Question: Condense the content of this figure into a single sentence.
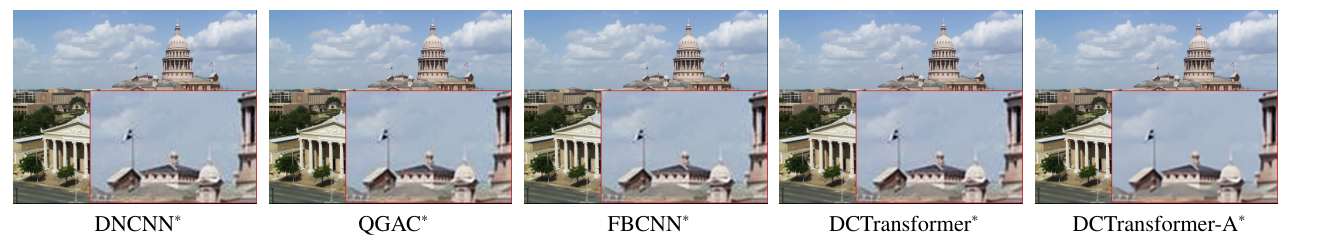
Answer: Visual examples of aligned/non-aligned double JPEG compressions and corresponding recovery results. Note that QF=(QF1, QF2) represents the image is firstly compressed with QF1 and then compressed with QF2, and marker ∗donates the non-aligned compression with a (4,4) pixel shift in between. The restored images of different methods are shown in the second and third rows. Our DCTransformer restores rich texture details (the rooftop, second row) and alleviates more artifacts (skies around the flag, third row). Please zoom in for the best view.